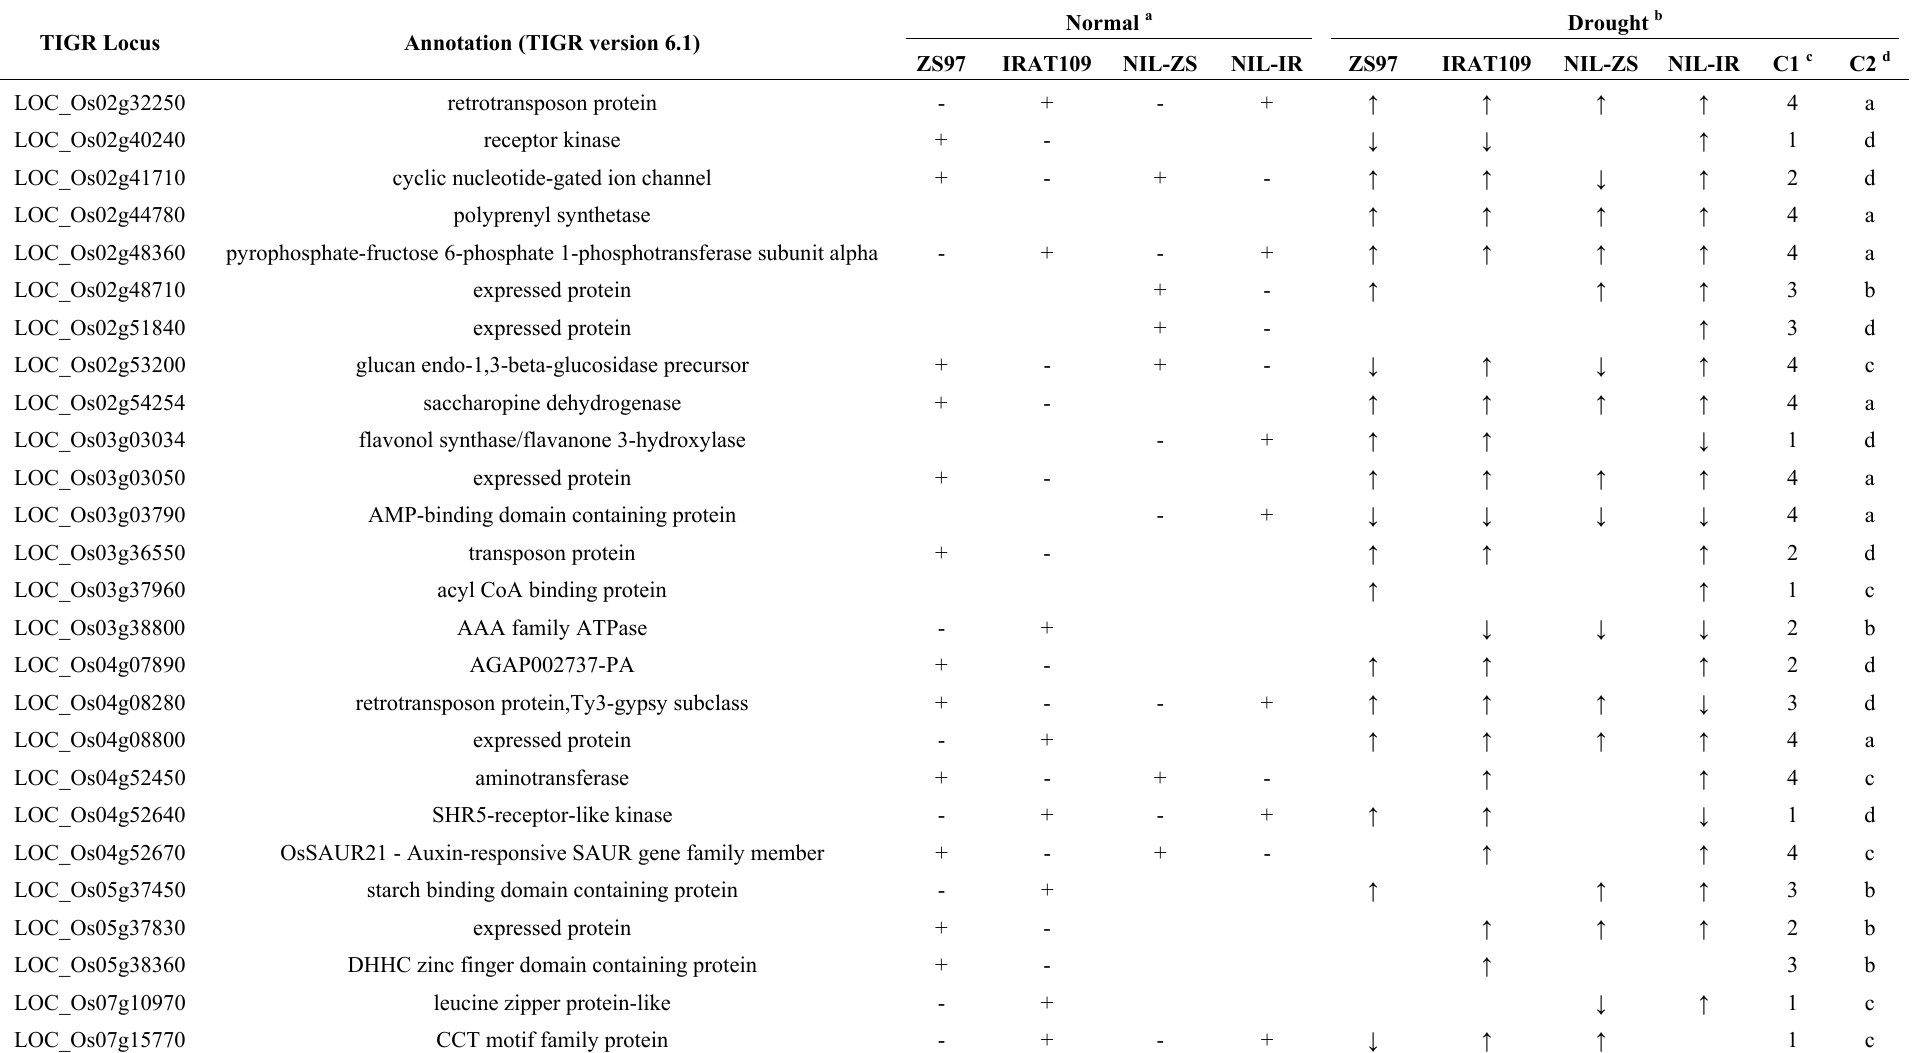
Table 3. Comparison of expression patterns of 36 drought-responsive